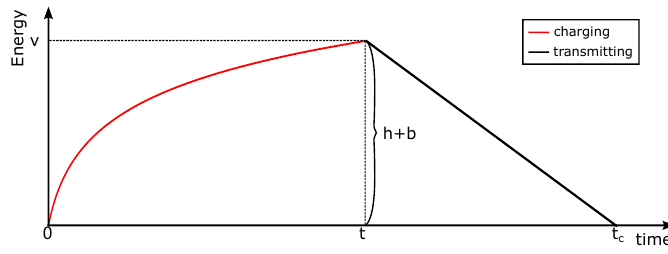
Figure 2. Energy receiving and data transmission